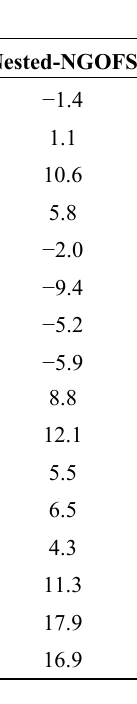
Table 2. Temperature hindcast skill comparison between nested NGOFS and NGOFS. RMSE (m) CF